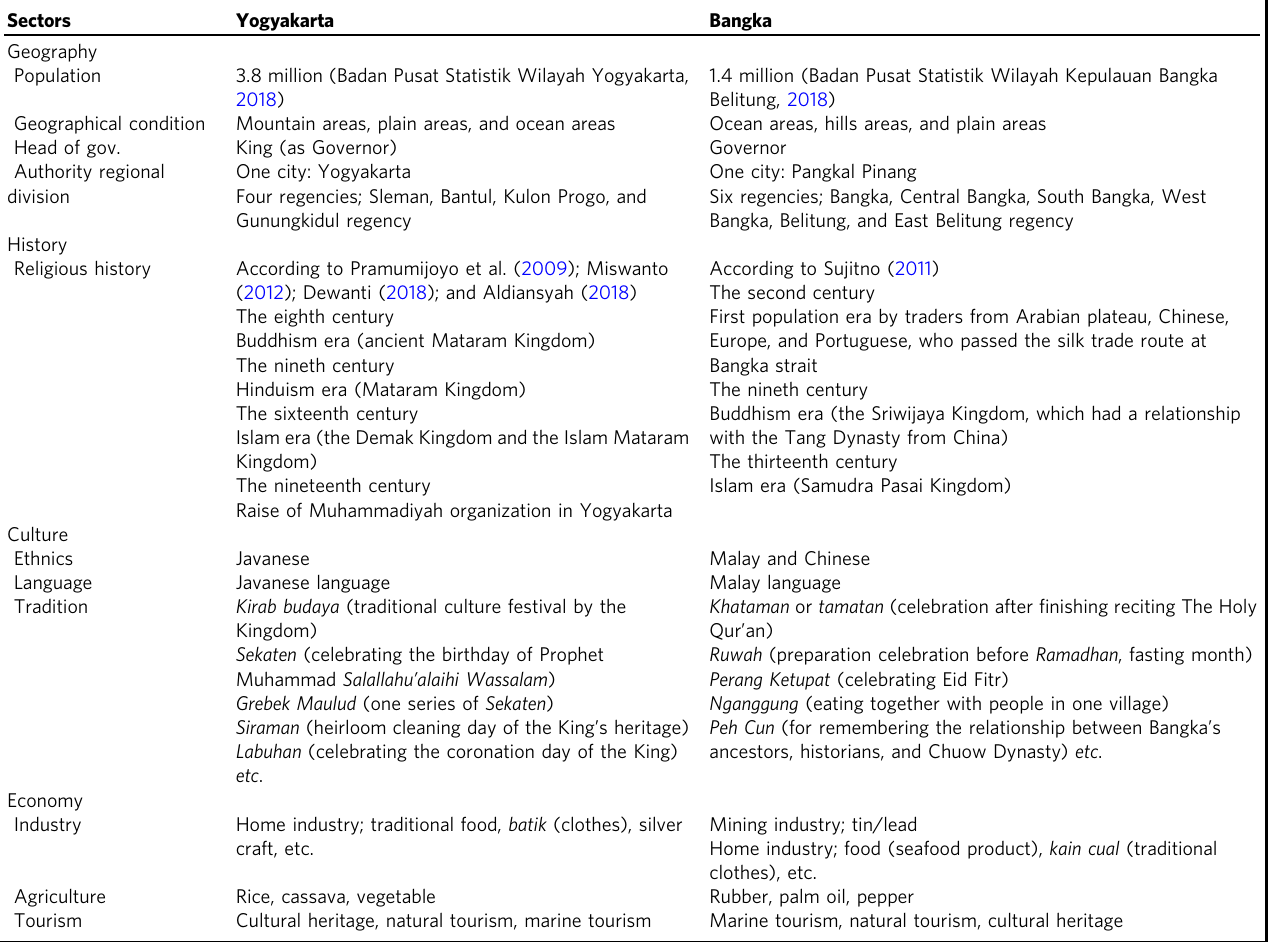
Table 1 Case contexts of Yogyakarta and Bangka. Sectors